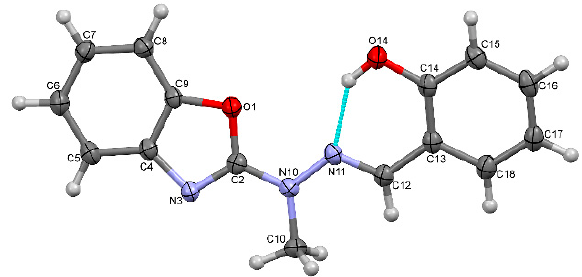
Figure 1. A perspective view of the Schiff base ligand HL . Ellipsoids are drawn at the 50% probability level, hydrogen atoms are represented by spheres of arbitrary radii, blue dashed line denotes the intramolecular hydrogen bond. Hydrogen atom has been localized on the basis of difference Fourier map (Figure S2) and successfully